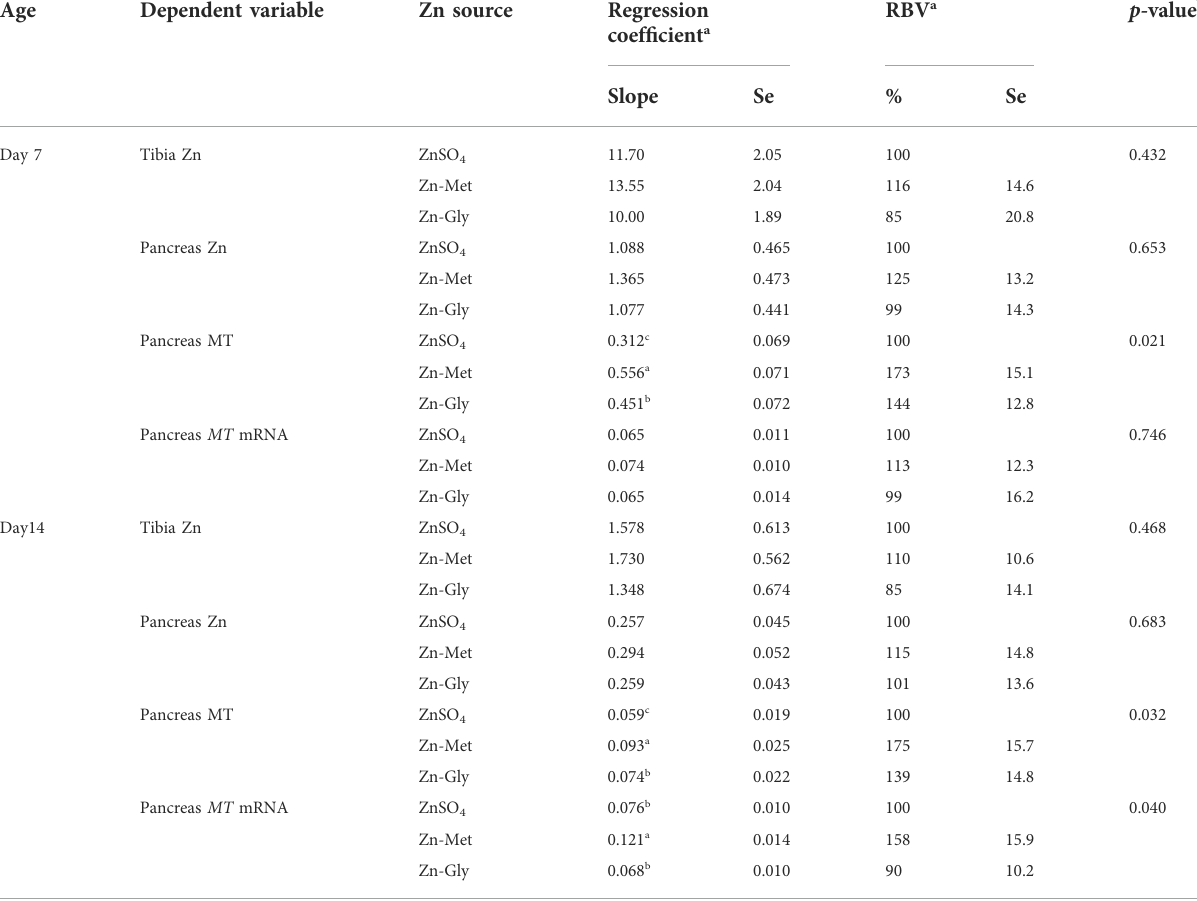
TABLE 7 Relative bioavailability values (RBVs) of zinc based on the multiple regression of different biological indices on supplemental zinc